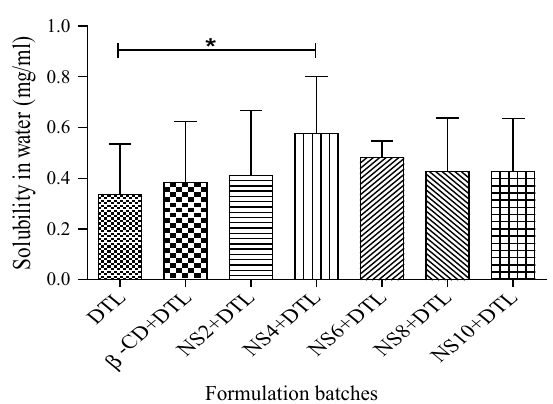
Fig. 2 Solubilization of DTL (dithranol), β-CD (β-cyclodextrin) and NS2 DTL, NS4 DTL, NS6 DTL, NS8 DTL and NS10 DTL + + + + + (different nanosponge batches with dithranol) in distilled water. All the values are presented in triplicate (mean SD); *Indicates p < 0.05 ± analyzed by one-way ANOVA, followed by Tukey’s test for multiple comparisons